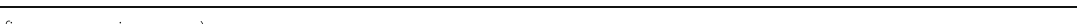
(See figure on previous page.) Fig. 2 PCR detection of CMV from cassava plantations in China. DNA gel electrophoresis of PCR amplification from cassava samples collected from different provinces in China using primer pairs of UPA/UPB ( a ) and SPA/SPB ( b ). GD, Guangdong Province; GZ, Guizhou Province; HN, Hainan Province; GX, Guangxi Province; FJ, Fujian Province; C – , healthy cassava; C+, SLCMV-Col-infected cassava; M, DNA marker (2000bp). c DNA sequencing chromatogram of PCR product for a single cassava sample (HN10, HN24, FJ2, or FJ4). A few double peaks in the chromatogram (marked by red arrows in AC1 gene) indicate co-infection of